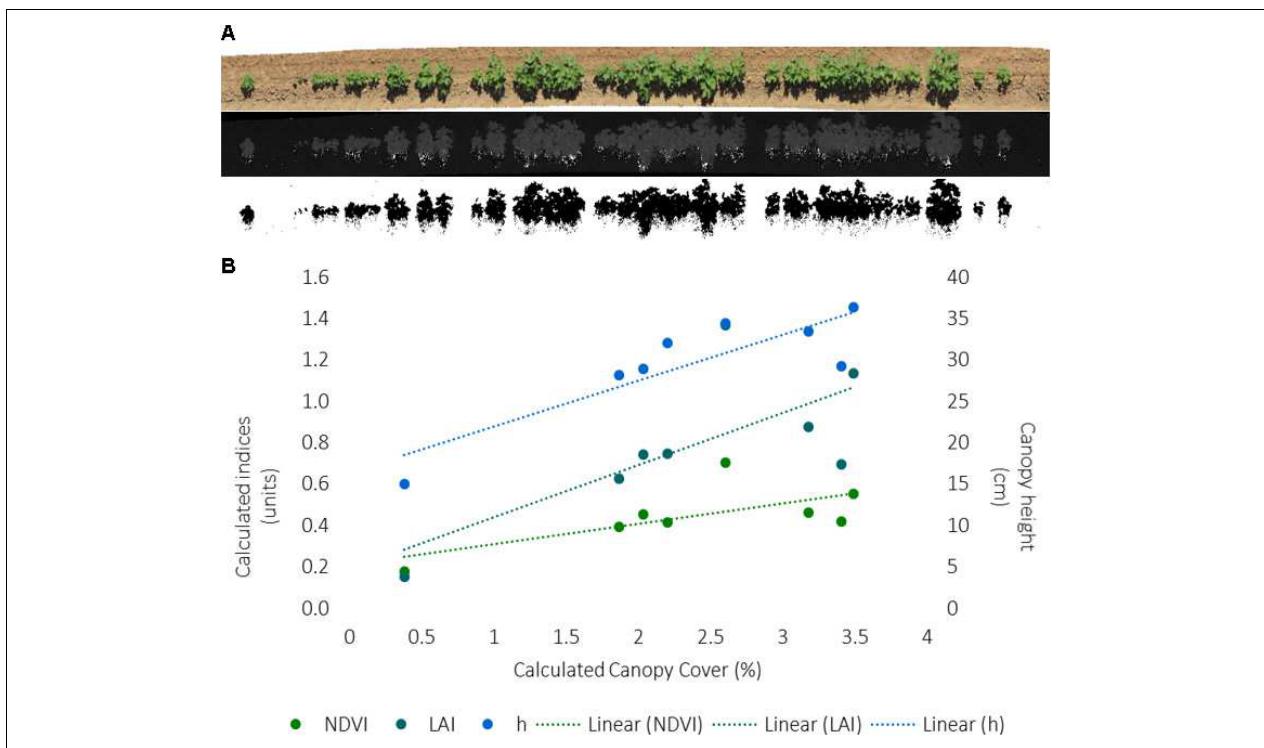
FIGURE 6 | (A) Image workflow to calculate canopy cover from RGB images collected for each 12.1 m row of each plot, including an orthomosaic from Agisoft Photoscan software, a hue band calculated from RGB data, and the inverse of the binary image from segmentation of green hue as outputted by Fiji Image J software. (B) Correlation between the RGB-derived canopy cover and PSC-derived normalized difference vegetative index (NDVI), LAI, and canopy height ( h ) values for the first eight plots on one collection day. The index units are to the left, canopy height units are to the right. The dashed line indicates the excel generated